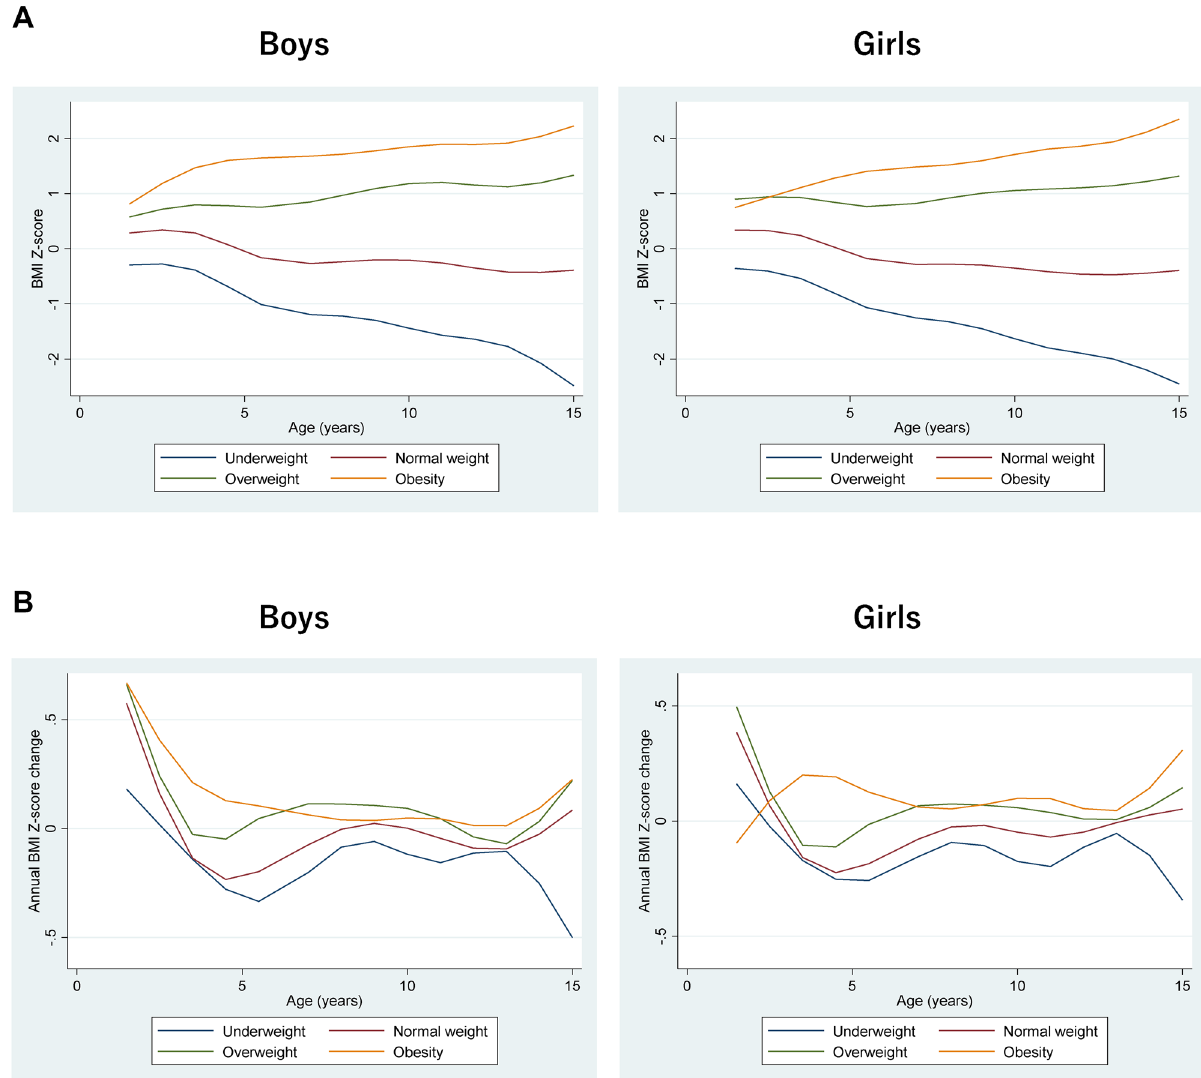
Figure 3. Dynamics of BMI Z-scores ( A ) and annual BMI Z-score changes ( B ) through age 15 years by gender.